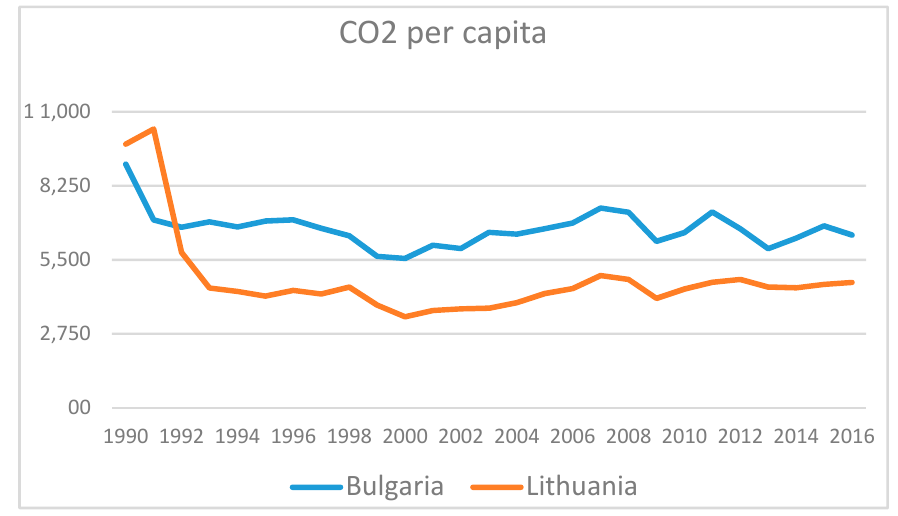
Figure 5. GHG emission per capita in Bulgaria and Lithuania, kgCO 2 eq/capita. Source: [39,40].